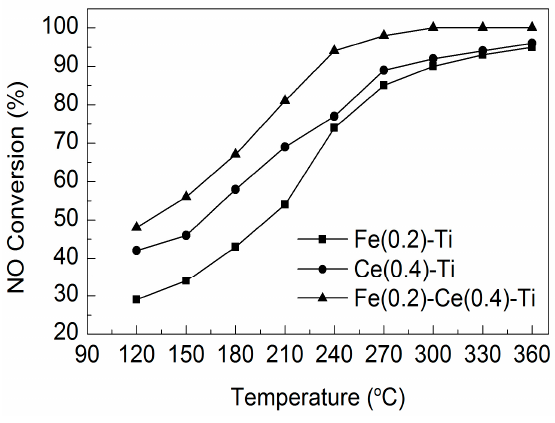
Figure 3. NO conversion over Fe(0.2)–Ti, Ce(0.4)–Ti, and Fe(0.2)–Ce(0.4)–Ti catalysts. Reaction